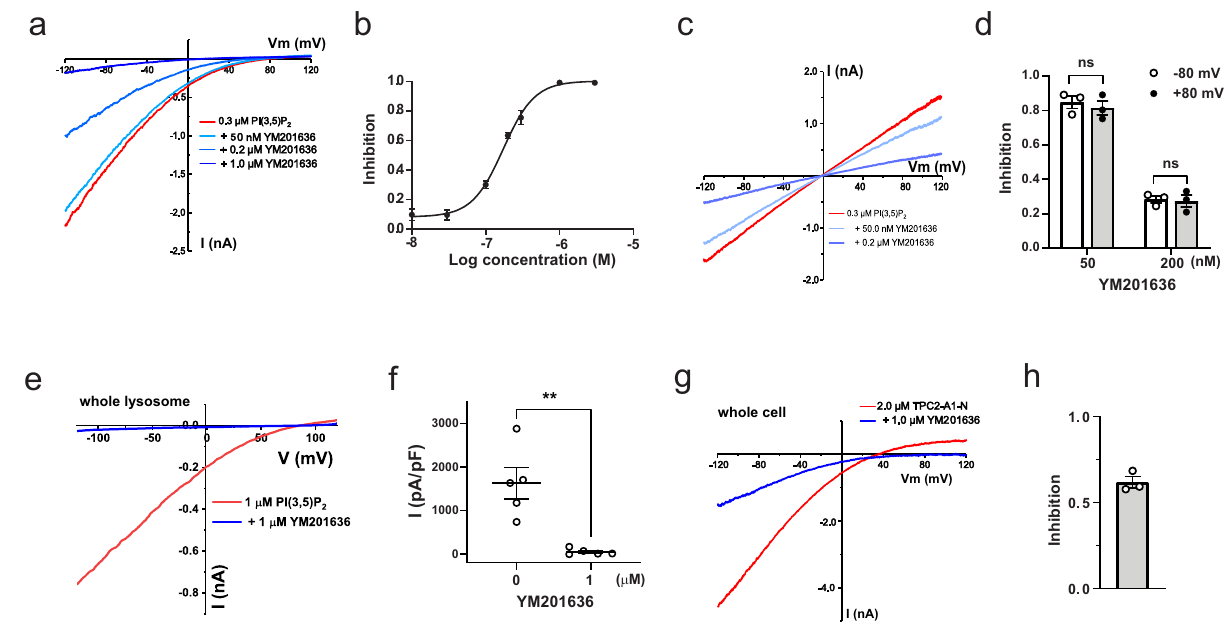
Fig. 2 YM201636 directly inhibits human TPC2 channels. a , b Representative current traces ( a ) and plot of the averaged dose response ( b ) of the inhibitory effect of YM201636 on the TPC2 PM Na + currents elicited by 0.3 μ M PI(3,5)P 2 . Path-clamp recording was done in inside-out con fi guration using asymmetric Na + (outside)/K + (inside) recording solutions. The data ( n = 6 – 8 for each data point) in ( b ) were fi t by a Hill equation. c Representative current traces of the TPC2 PM Na + currents recorded in inside-out con fi guration using symmetric Na + recording solutions in the absence and presence of 50 nM or 0.2 µ M YM201636. d Averaged inhibitory effects of YM201636 on the outward and inward TPC2 PM currents recorded at + 80 and − 80 mV as shown in ( c ). e , f Representative current traces ( e ) and averaged plot ( f ) of the effects of 1 µ M YM201636 on 1 µ M PI(3,5)P 2 -induced TPC2 Na + currents in whole lysosome patch-clamp recording using asymmetric K + (cytosolic)/Na + (lumenal) recording solutions. g , h Representative current traces ( g ) and averaged plot at − 120 mV ( h ) of the effect of 1 µ M YM201636 perfused on the extracellular side on TPC2 PM channel currents elicited by extracellularly applied TPC2-A1-N in whole cell patch-clamp recording using asymmetric Na + (outside)/K + (inside) recording solutions. The averaged data are presented as mean value ± SEM. Unpaired Student ’ s t -test (two tailed) was used to calculate p values. ** and ns are for p values ≤ 0.01 and > 0.05,